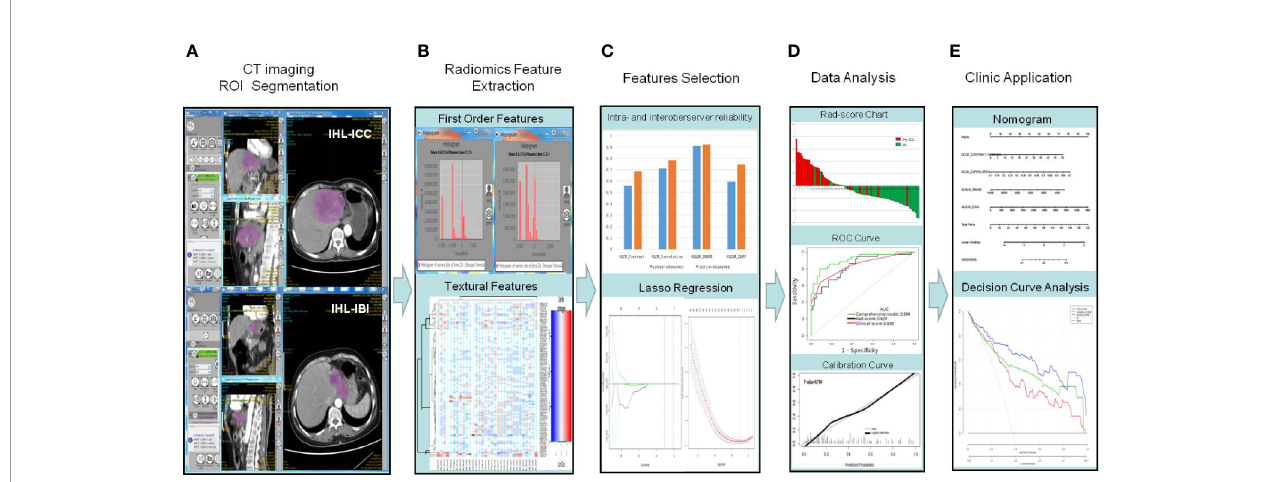
FIGURE 2 | Work fl ow of required steps in this current study. (A) Manual segmentation on arterial phase CT scans; (B) Quanti fi cation of tumor intensity, shape, and texture through radiomic features collected by LIFEx software from inside the de fi ned tumor contours on CT images. (C) For feature selection, two successive steps are the reliability assessment regarding the extracted features, followed by the LASSO method. A radiomic signature was obtained by combining the selected features by their respective coef fi cients, linearly. (D) By measuring the area under a receiver operating characteristic (ROC) curve and the calibration curve, the performance of the prediction model can be analyzed. (E) A radiomic nomogram was built in order to provide clinicians with a visual tool through the use of the selected covariates, followed by decision